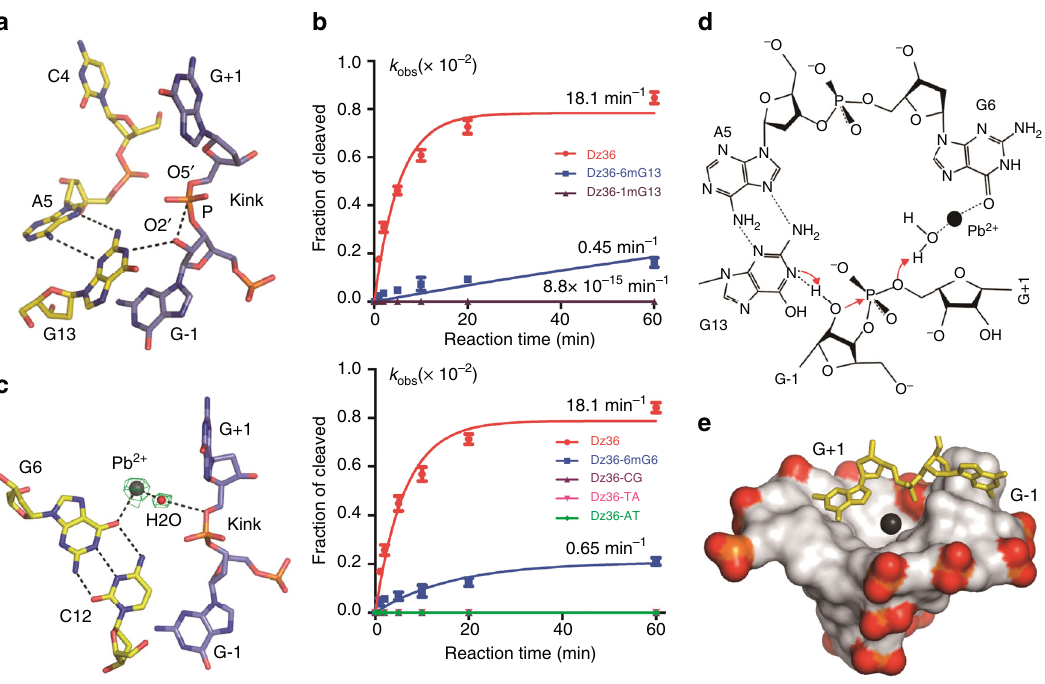
Fig. 3 Cleavage site assembly and proposed catalytic mechanism. a Detailed conformations of the GG-kink and G13 observed in the DNAzyme(2 ′ -OMe-G) structure. b Comparison of the catalytic activities of the wild-type DNAzyme, mutants with methylated G6 or G13, and mutants with G6:C12 replaced with other Watson – Crick base pairs. Due to overlapping with Dz36-AT, the curves for Dz36-CG and Dz36-TA are not visible. c Coordination of Pb 2+ and the catalytic water observed in the DNAzyme-Pb 2+ structure. The annealed F o – F c omit maps for Pb 2+ and the water molecule are contoured at 3.0 σ level and colored in green. d Proposed mechanism for the RNA substrate cleavage by 8 – 17 DNAzyme. The N1 atom of G13 deprotonates the 2 ′ -OH group of the attacking G − 1 residue. The O6 atom of G6 coordinates with Pb 2+ , which will activate the catalytic water molecule (general acid) to provide a proton to the O5 ′ atom of the leaving residue G+1. e Surface representation showing the preformed cation binding cage. The Pb 2+ is shown as a black sphere. The G − 1 and G+1 residues are shown as stick models in yellow. The phosphorus atoms and the oxygen atoms of the backbone phosphate groups of the DNAzyme are colored in orange and red,